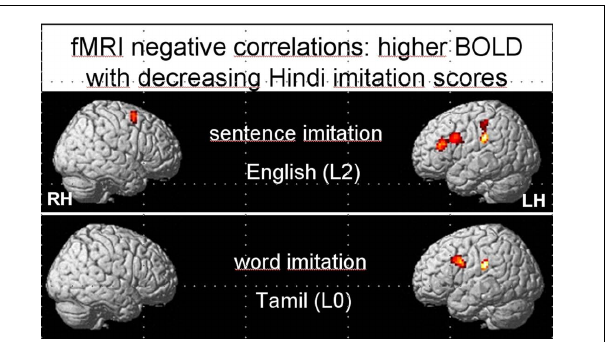
FIGURE 5 | Functional magnetic resonance imaging differential effects for the low ability group (group versus group comparisons): upper panel: during (overt) “sentence imitation” in L1 (first language) German and L2 (second language) English. Lower panel: during (overt) “word imitation” in L2 English and “L0” (unknown language)Tamil. Flexible factorial ANOVA was used to perform the group versus group analyses.The comparison “high ability versus low ability group” yielded no significant remaining activations for the “high” ( N = 9) group (no brain maps presented).The comparison depicted here represents “low ability